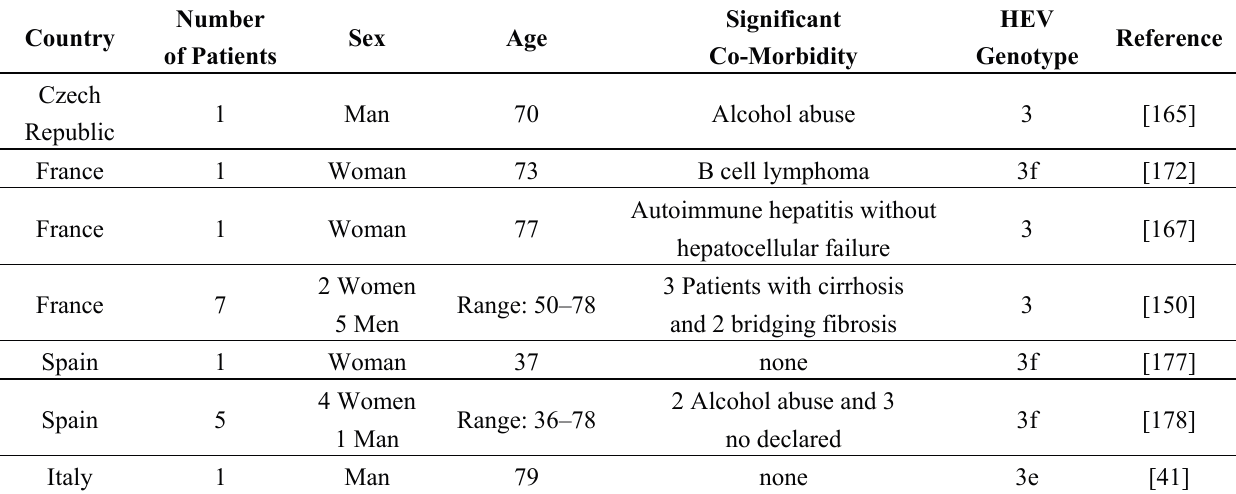
Table 2. Fulminant hepatitis E cases in